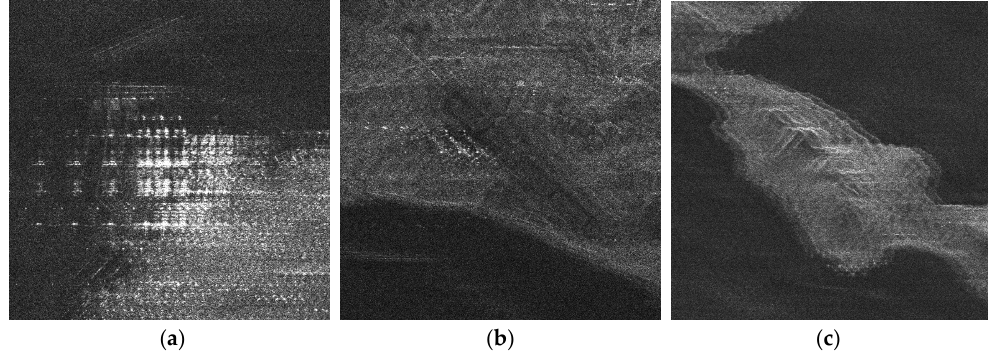
Figure 21. The enlarged view of three areas in the result of RD algorithm when data is periodically missing along azimuth direction. ( a ) Area A1. ( b ) Area A2. ( c ) Area A3.